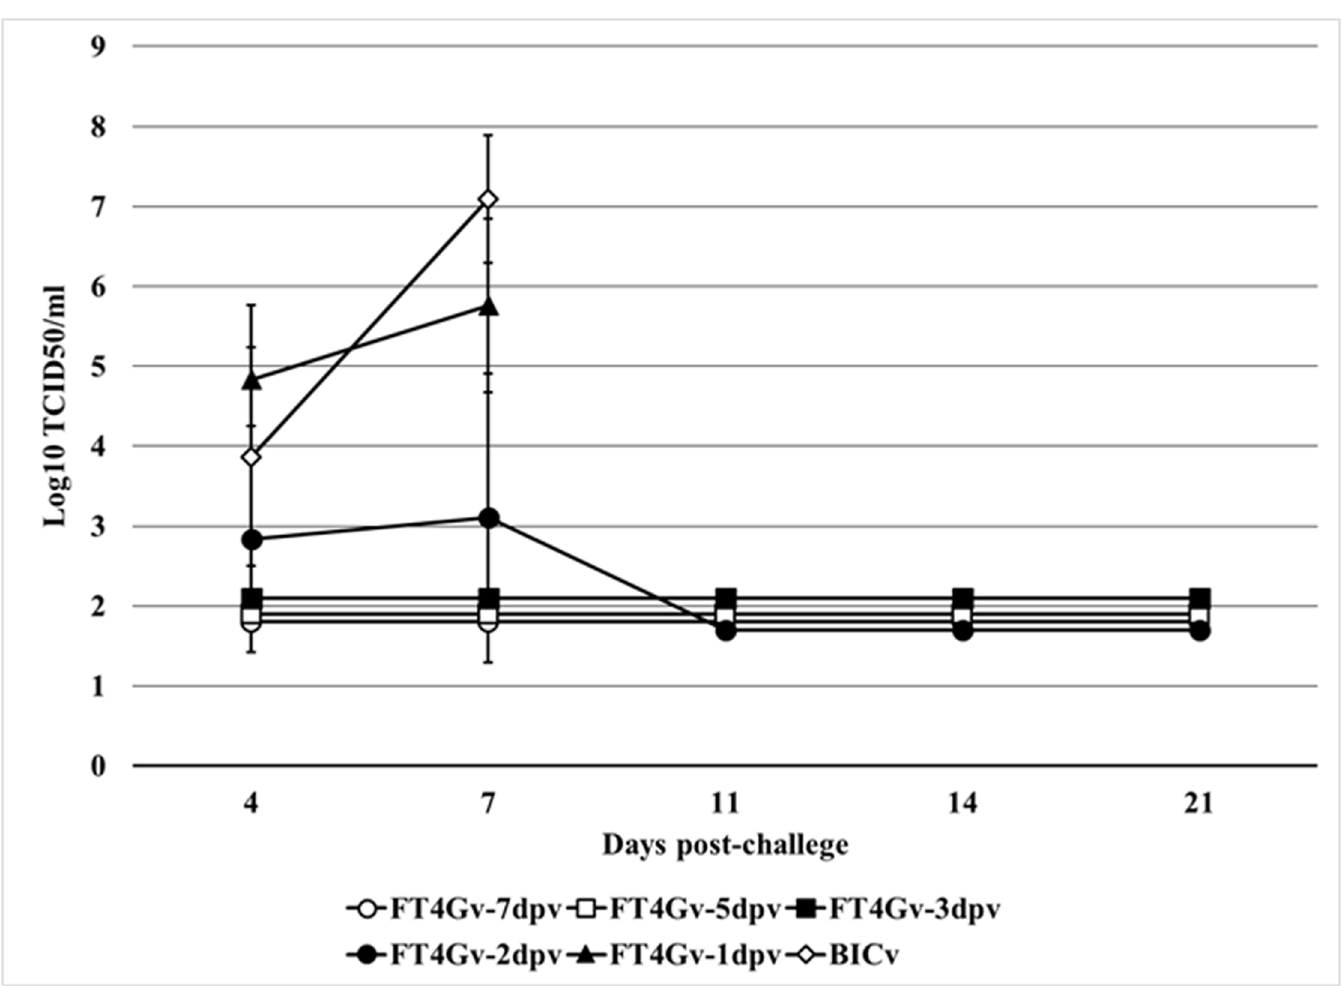
Fig 2. Viremia in FlagT4Gv-infected animals challenged at different times post-infection with virulent BICv. Data represent averagetiters and SD of 5 animals in each time point. Titers, expressedas TCID 50 /mL, correspondexclusively to presenceof BICv that was determinedby immunocytochemistry using mAbs WH303 which specificallydetects BICv. Sensitivityof virus detection: (cid:21) 1.8 TCID 50 /mL.